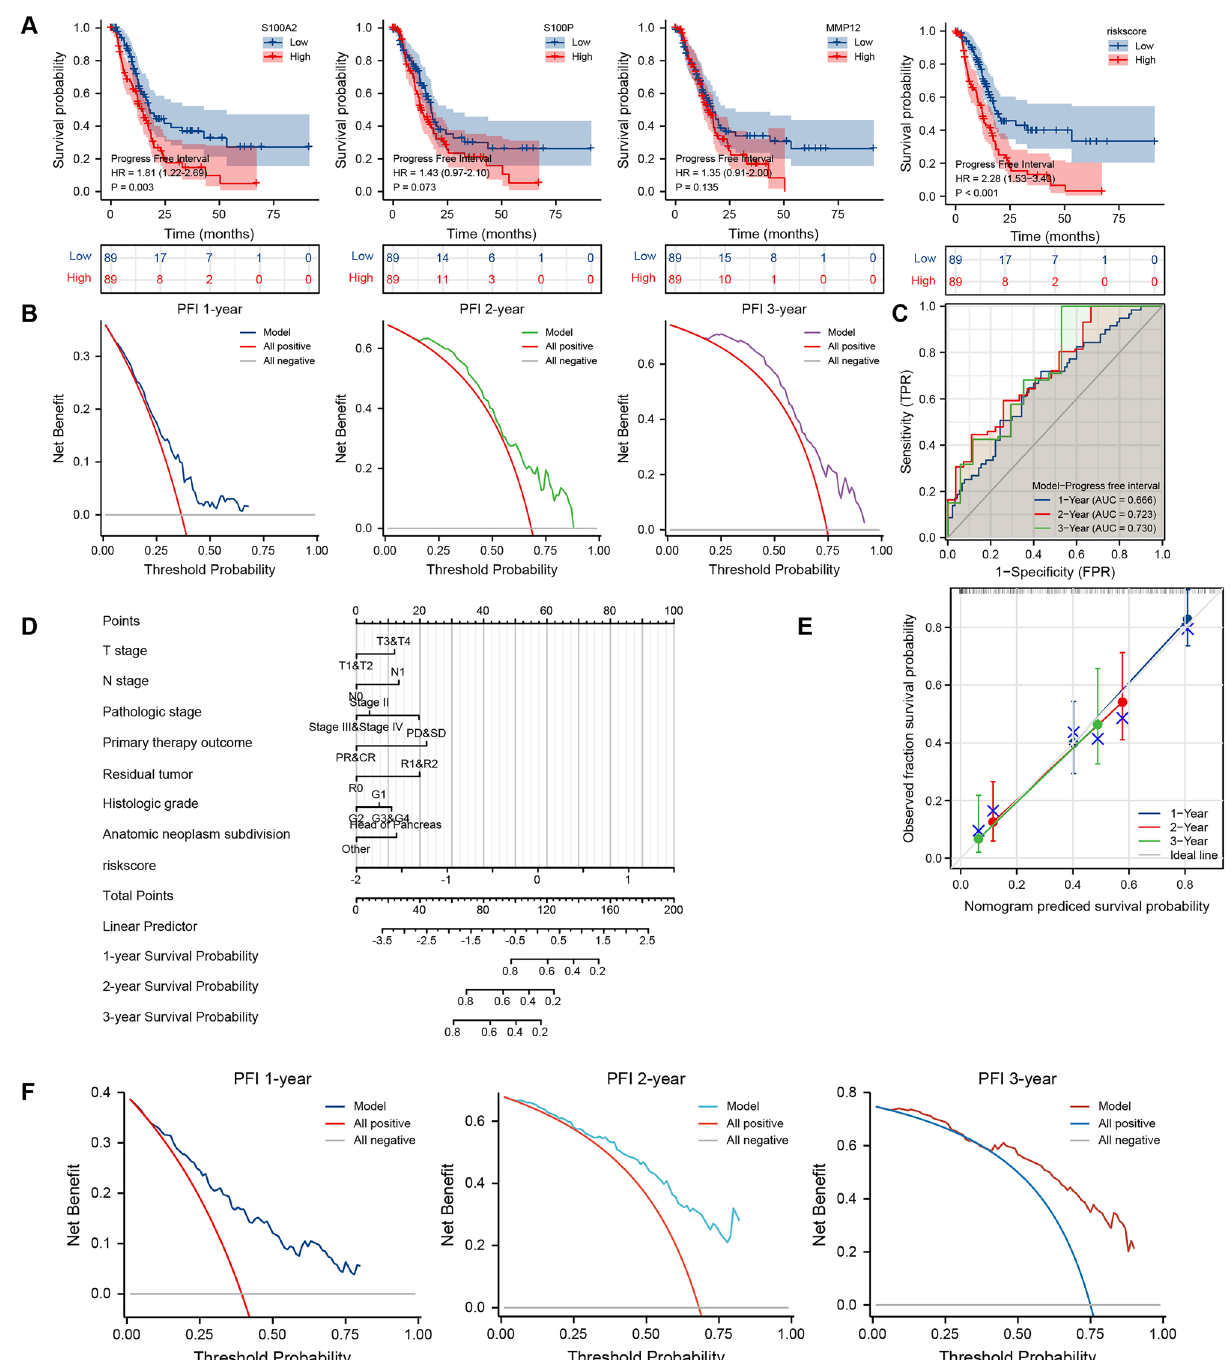
Figure 10. Establishment and assessment of PAAD-IRGS-based nomograms for PFI in TCGA-PAAD. ( A ) Single-gene and PAAD-IRGS survival analysis of PFI in PAAD; ( B ) the time-dependent ROC curve of the PAAD-IRGS for predicting 1, 2, and 3-year PFI; ( C ) decision curve analysis for evaluating the PAAD-IRGS; ( D ) an PAAD-IRGS-based nomogram included with 7 clinical components predicting 1, 2, and 3-year PFI of PAAD; ( E ) nomogram calibration curve for 1, 2, and 3-year. ( E ) Decision curve analysis for evaluating the net benefits of nomogram at 1, 2, and 3 years. PFI progress free interval; * P < 0.05, ** P < 0.01, *** P <